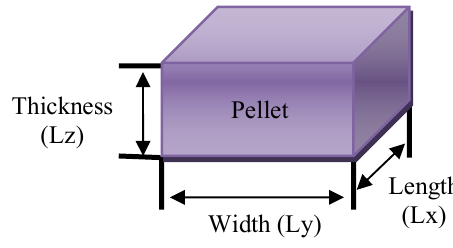
Figure 2: The description of the pellet model.